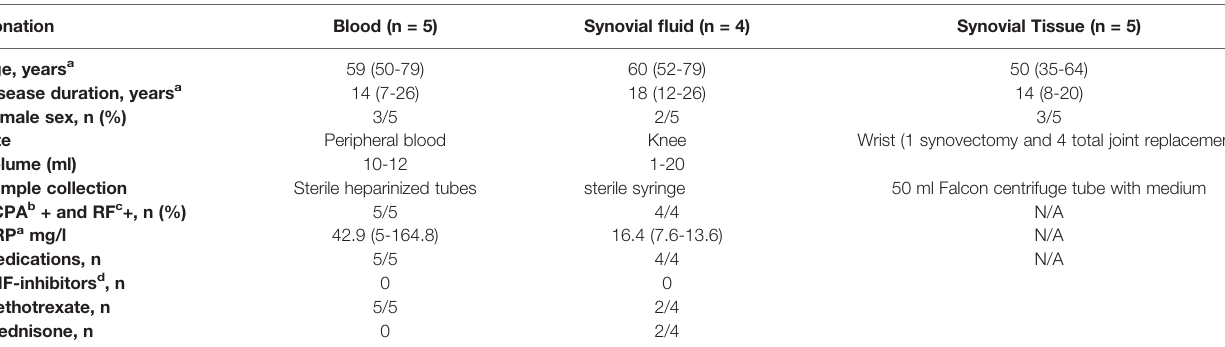
TABLE 1 | RA Patient